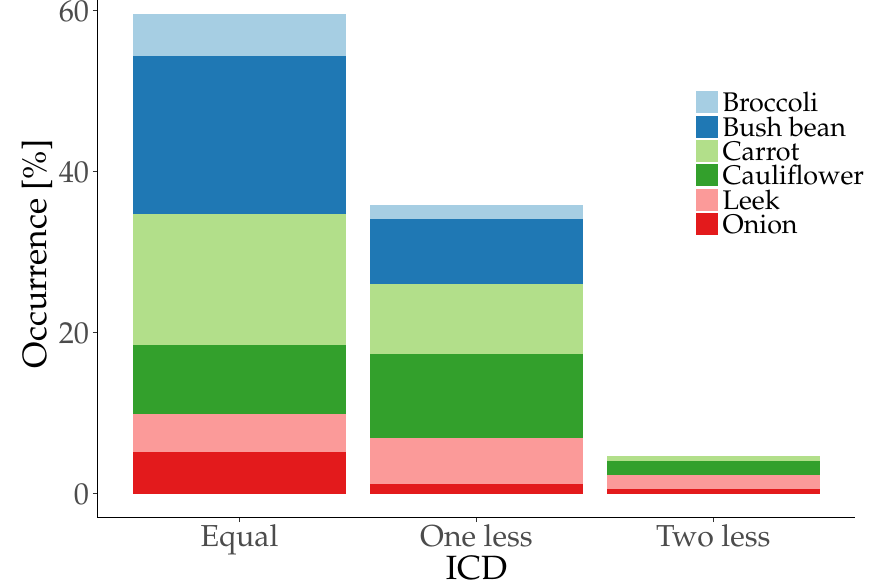
Figure 6. Occurrence(%)ofirrigationcountdifferences, ICD,of GS P 2 relativeto GS FAO 56 ( GS P 2 as simulated using the six vegetable